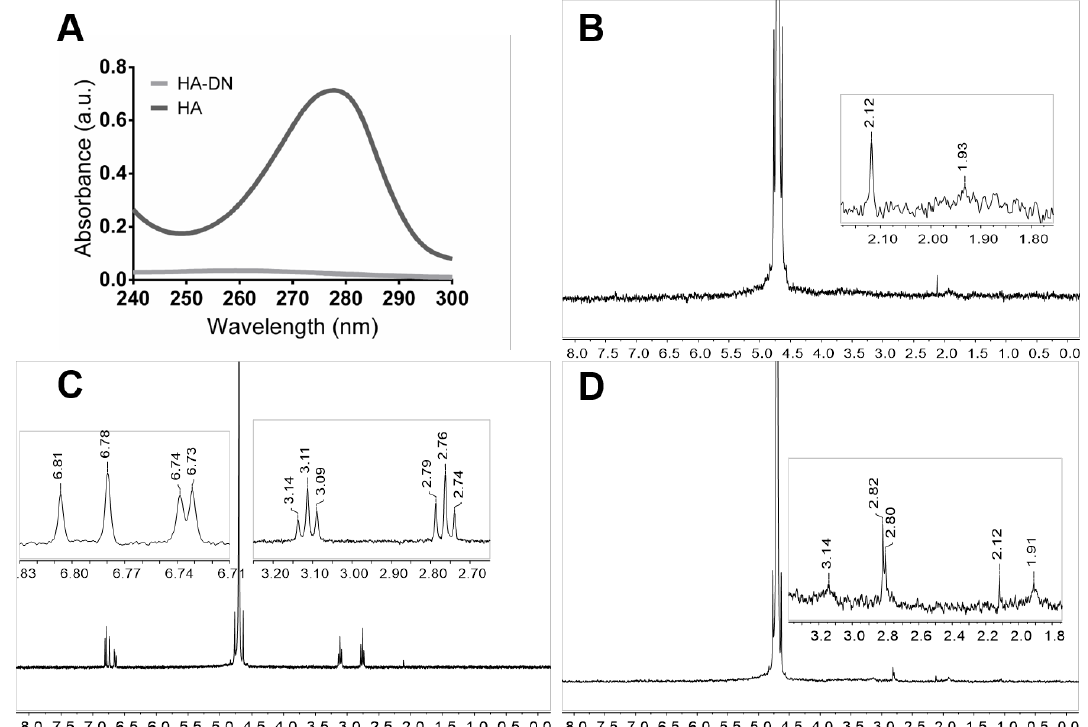
Figure 2. Characterization of conjugated dopamine-modified hyaluronic acid. ( A ) Ultraviolet–visible (UV–Vis) spectra of the control (HA) and the catechol-based conjugate (HA-DN). 1 H-nuclear magnetic resonance (NMR) spectra of ( B ) HA; ( C ) DN and ( D ) the synthesized conjugate HA-DN, all with an expanded view. a.u.: Arbitrary units.